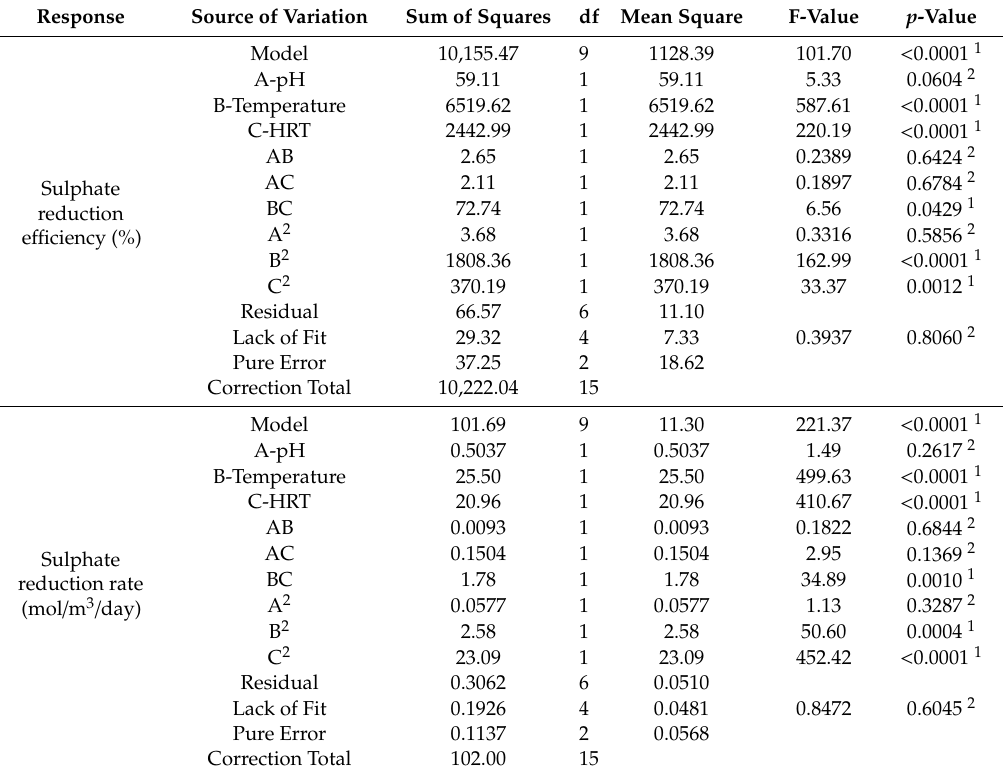
Table 3. ANOVA results for the fitted quadratic